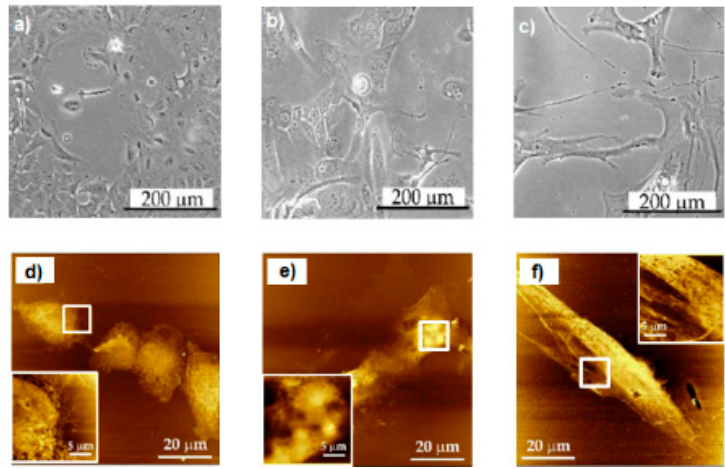
Figure 26. Soft X-ray images of fixed epidermal cells (Keratinocytes), FOV = 60 × 60 μ m 2 ( a ) and 25